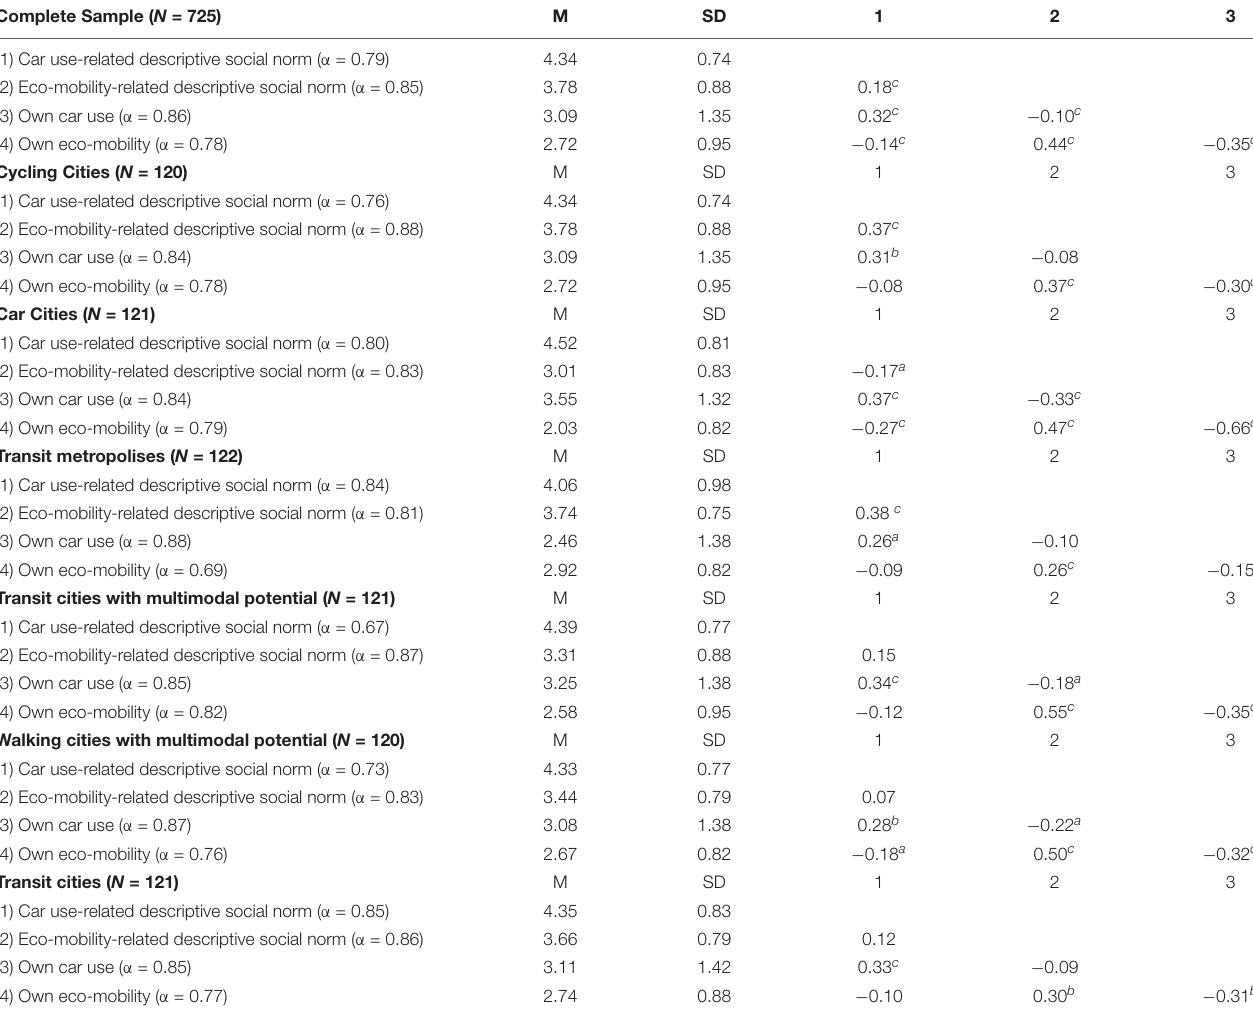
TABLE 1 | (Study 1) Labels, Cronbach’s α , means, SDs, and correlations of the descriptive norms and individual mobility behavior mean value indices ( N = 725). Complete Sample ( N =